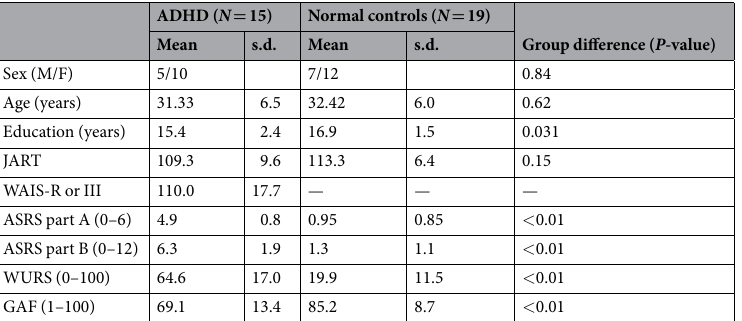
Table 1. Demographic characteristics of the participants. M, male; F, female; JART, Japanese version of the National Adult Reading Test; WAIS-R or III, Wechsler Adult Intelligence Scale–Revised or 3rd Edition; ASRS, Adult ADHD Self-Report Scale; WURS, Wender Utah Rating Scale; GAF, Global Assessment of